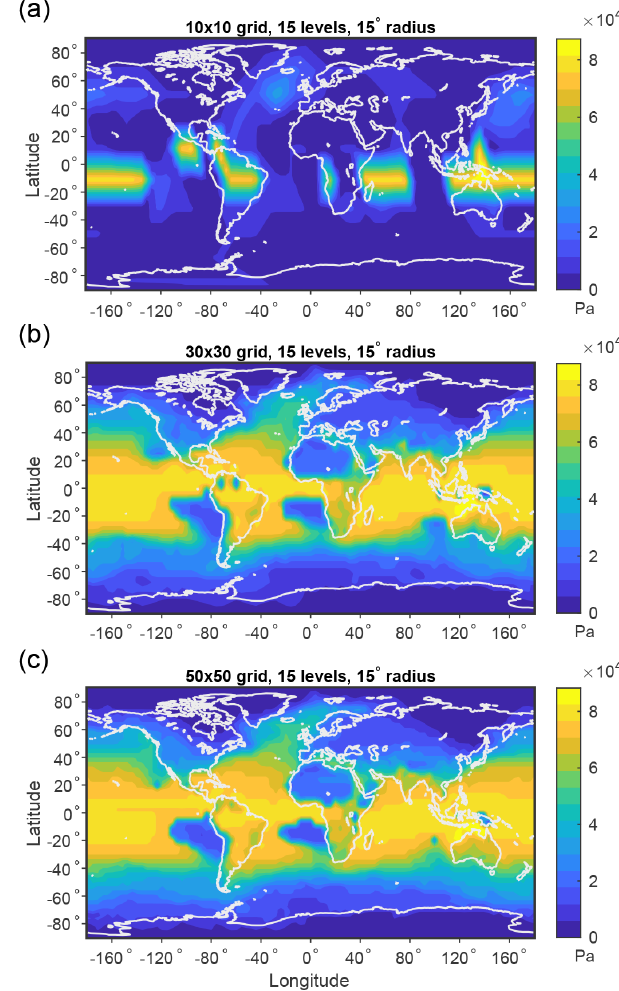
Figure B1. Local MAPE based on the DJF climatological mean over 1979–2018 for grids of varying horizontal resolution: (a) 200 surface grid cells (a 10 × 10 grid in each hemisphere), (b) 1800 sur- face grid cells (a 30 × 30 grid in each hemisphere), and (c) 5000 sur- face grid cells (a 50 × 50 grid in each hemisphere). All results shown in this figure use 15 pressure levels and subdomains of geodesic ra- dius of 15 ◦ (1670km).